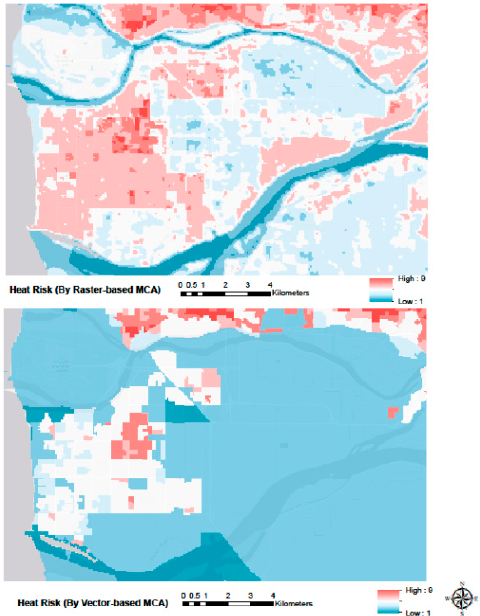
Figure 5. Heat risk maps from the raster-based ( Top ) and vector-based ( Bottom ) approaches zoomed into the city of Richmond. There is substantial discrepancy between the two approaches in the classification of heat health risk for this area.